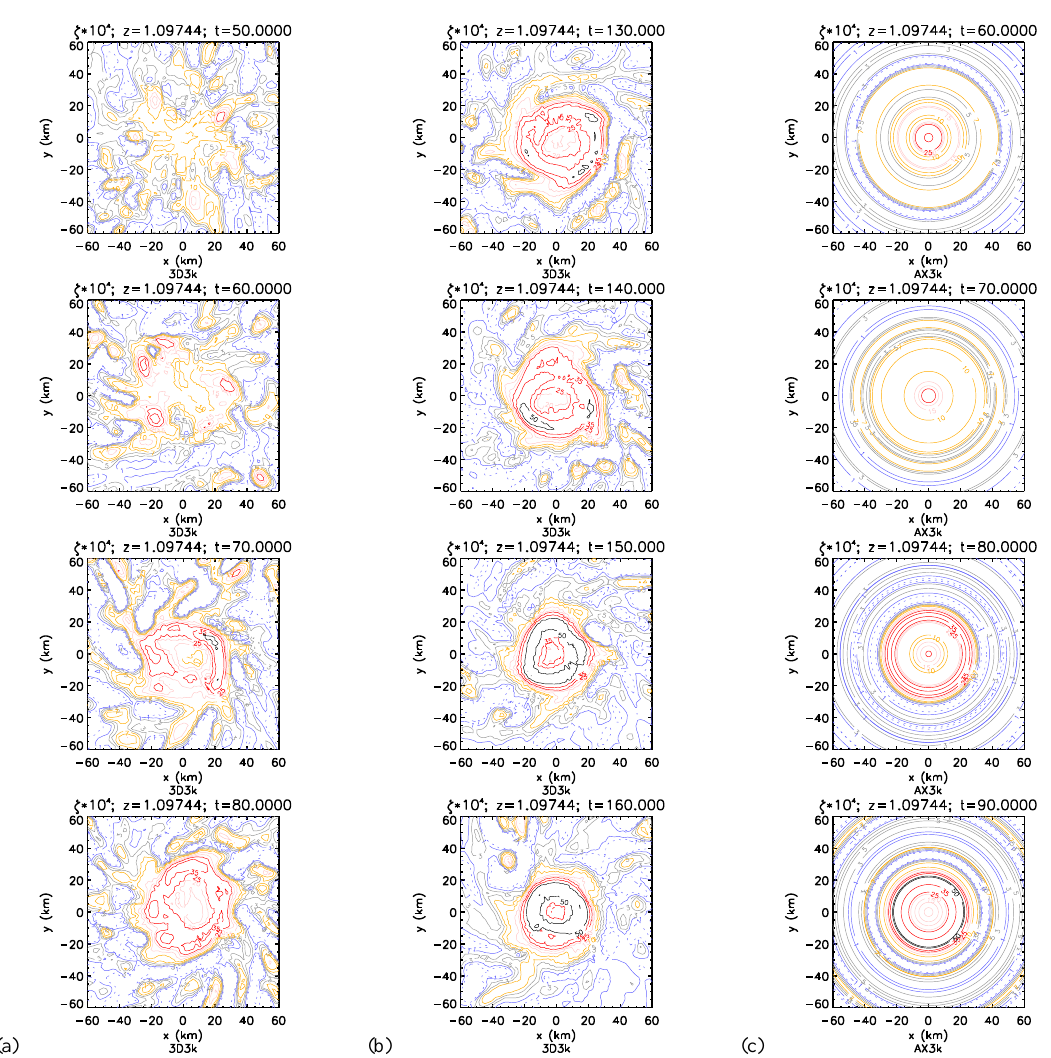
Fig. 2. Contour plots of relative vorticity ζ times 10 4 at z = 1km at a sequence of times (a) and (b) (left-middle) from the simulation 3D3k and (c) (right) from simulation AX3k spanning periods of rapid intensification. The time period shown is between (a) 50–80h and (b) 130–160h for the 3D3k experiment and (c) 60–90h in the AX3k experiment. Contours (s − 1 ) are − 1 and 1 (blue); 3 and 5 (gray); 7 and 10 (orange); 15 and 20 (pink); 25 and 35 (red); and 50 and 75 (black).